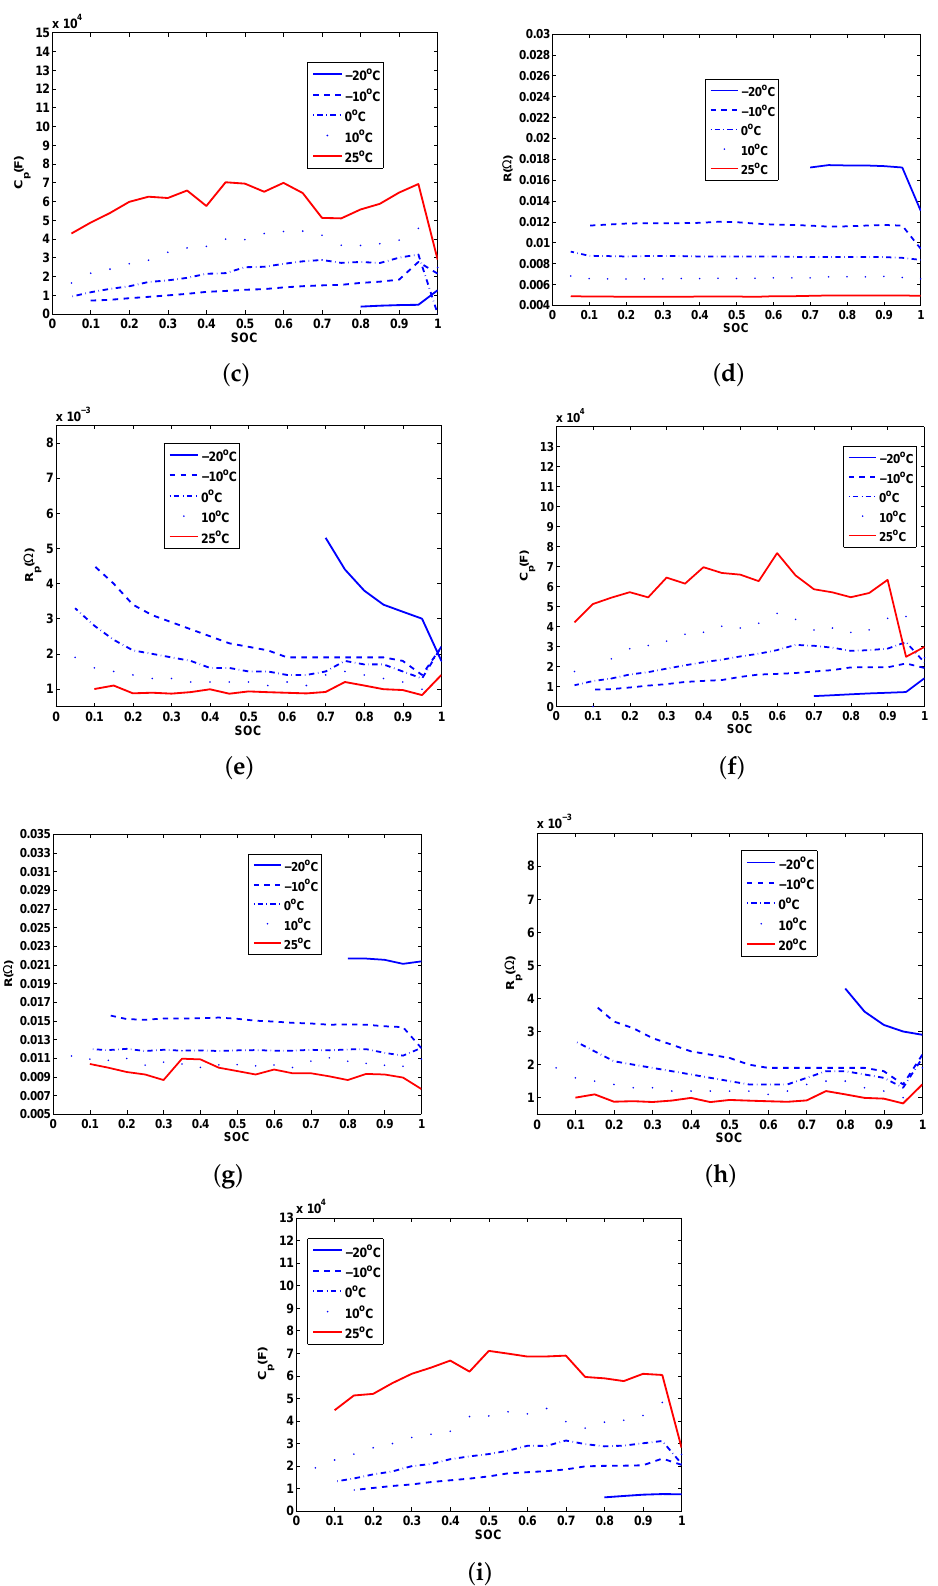
Figure 6. Experimental results for R-SOC, R p -SOC, C p -SOC at various temperatures. ( a – c ) applied the current of Figure 4a to the battery; ( d – f ) applied the current of Figure 4c to the battery; ( g – i ) applied the current of Figure 4e to the